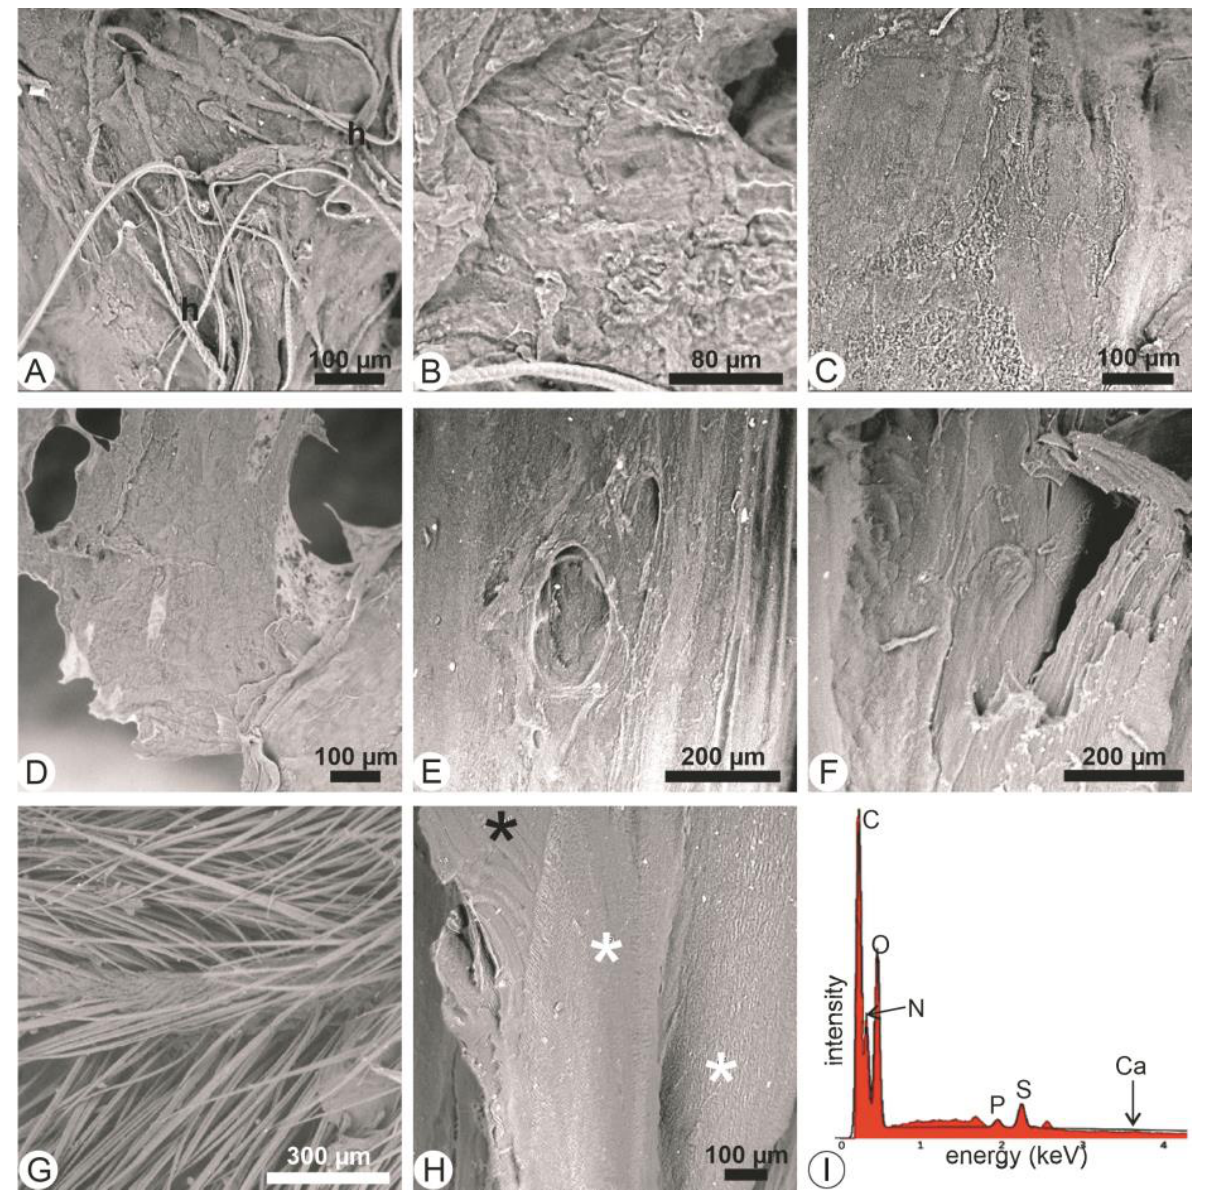
Figure 2. Acidic hydrolyses. ( A ). Hairs on the scapula ( Apodemus ); HCl pH 1. ( B – D ). Haversian structure hidden by flesh remains; HCl pH 1. ( E – F ). Tibia of the same sample showing similar features; HCl pH 2.43. ( G ). Hairs in the articular zone; HCl pH 2.43. ( H ). Localization of electron microprobe spectra : white stars. ( I ). Spectra showing the loss of Ca and P in acidic etched bones.